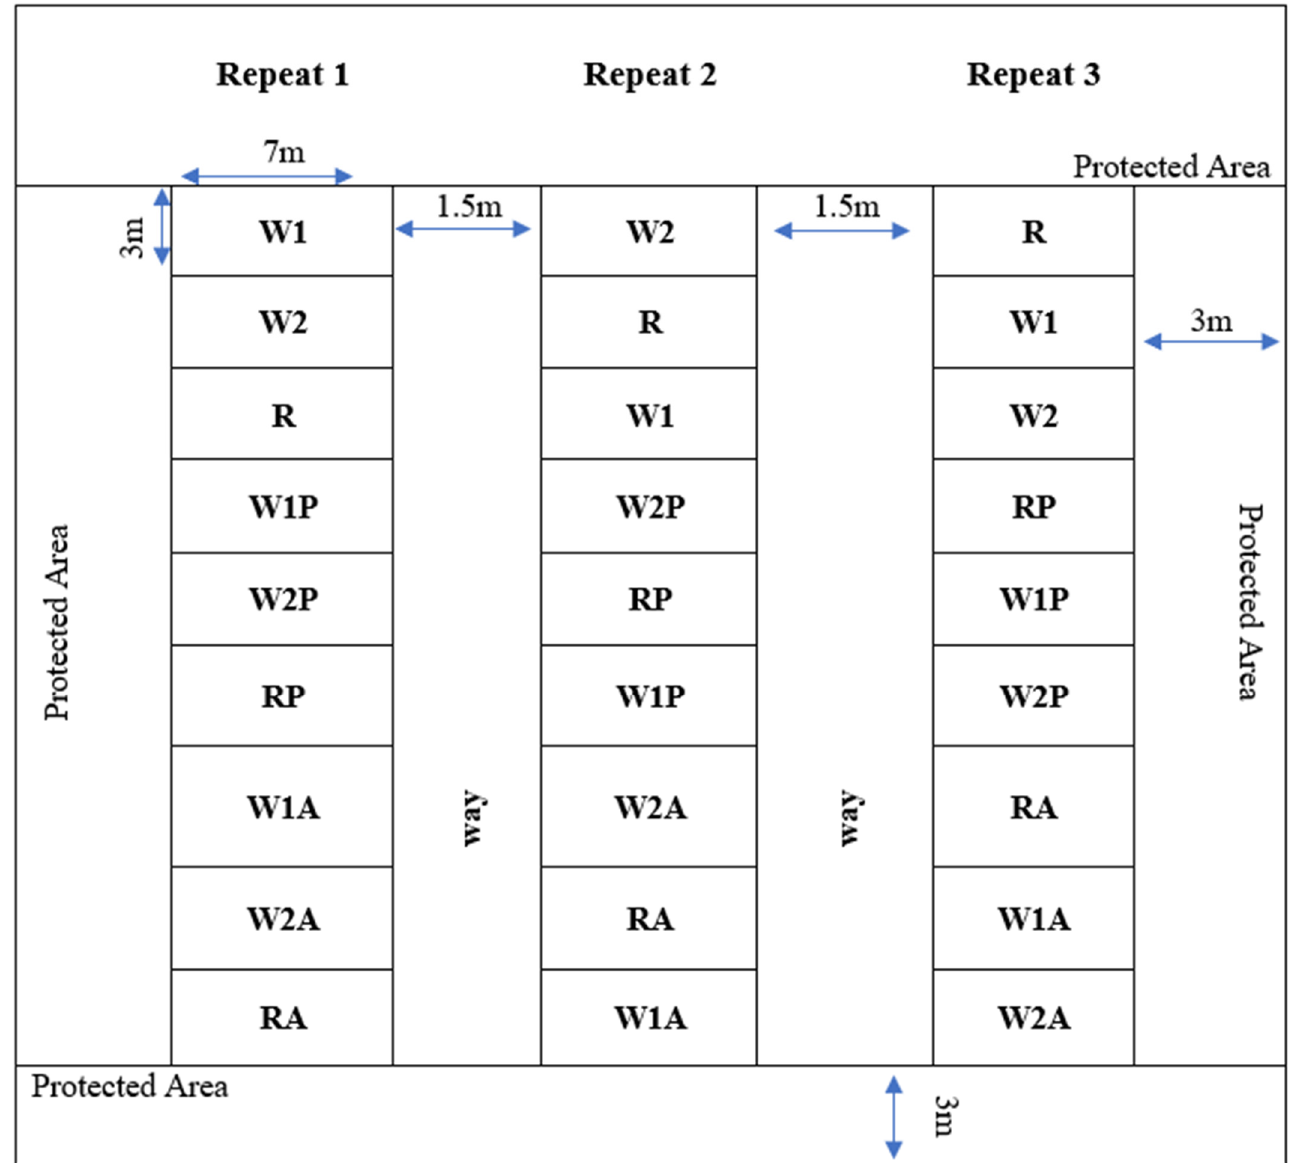
Figure 1. Field layout of cereals mono cropping and cereals–legumes mixed cropping in the exper- iment.